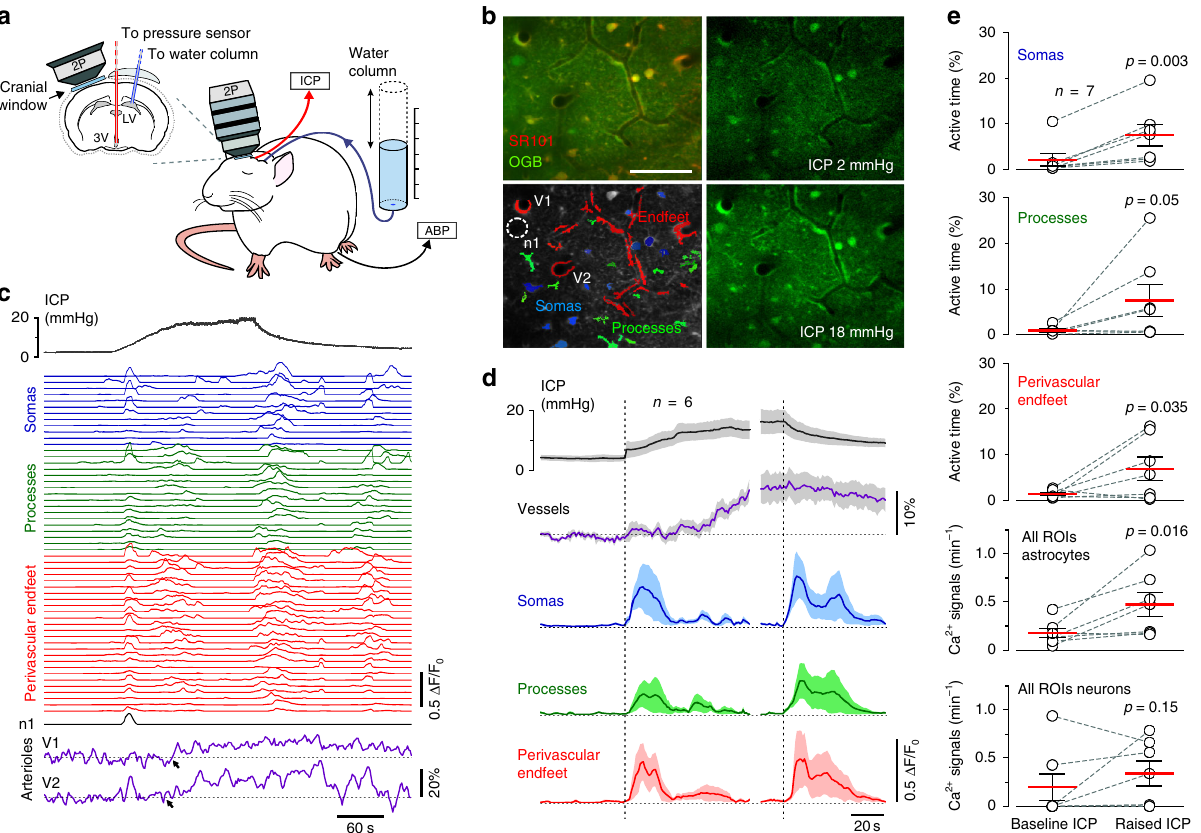
Fig. 2 Astrocytes sense decreases in brain perfusion. a Diagram of the experimental setup in anesthetized rats instrumented for the recordings of intracranial pressure (ICP), systemic arterial blood pressure (ABP) and two-photon imaging of [Ca 2 + ] i in cortical astrocytes using a Ca 2 + -sensitive dye Oregon Green BAPTA 1 AM (OGB). b Representative images illustrating the identi fi cation of cortical astrocytes using sulforhodamine 101 (SR101) labeling and levels of OGB fl uorescence at baseline (ICP = 2 mmHg) and in conditions of raised ICP (ICP = 18 mmHg). Regions of interest (ROIs) corresponding to astroglial somas, major parenchymal processes and perivascular endfeet detected by automated software are highlighted. One SR101-negative cell (n1) was identi fi ed in this fi eld of view. Scale bar: 100 μ m. c Representative traces derived from the recording illustrated in (b) showing [Ca 2 + ] i responses of individual cell bodies, major processes and endfeet of cortical astrocytes as well as changes in the diameter of penetrating arterioles induced by changes in ICP. Arrows point to the onset of vascular responses. d Averages (means ± SEM) of [Ca 2 + ] i signals in cell bodies, processes and endfeet of cortical astrocytes and changes in the diameter of penetrating arterioles (16 vessels) plotted in relation to the averaged trace of ICP changes recorded in 6 animals and focusing on time periods around the raised ICP stimulus onset and offset. e Summary data illustrating the effect of raised ICP on Ca 2 + active time (% of time when [Ca 2 + ] i is elevated) recorded in somas, major processes and endfeet of cortical astrocytes as well as the frequency of [Ca 2 + ] i signals in astrocytes and neurons. The data are shown as individual values and means ± SEM. p- values, paired t -test. Source data are provided as a Source Data fi